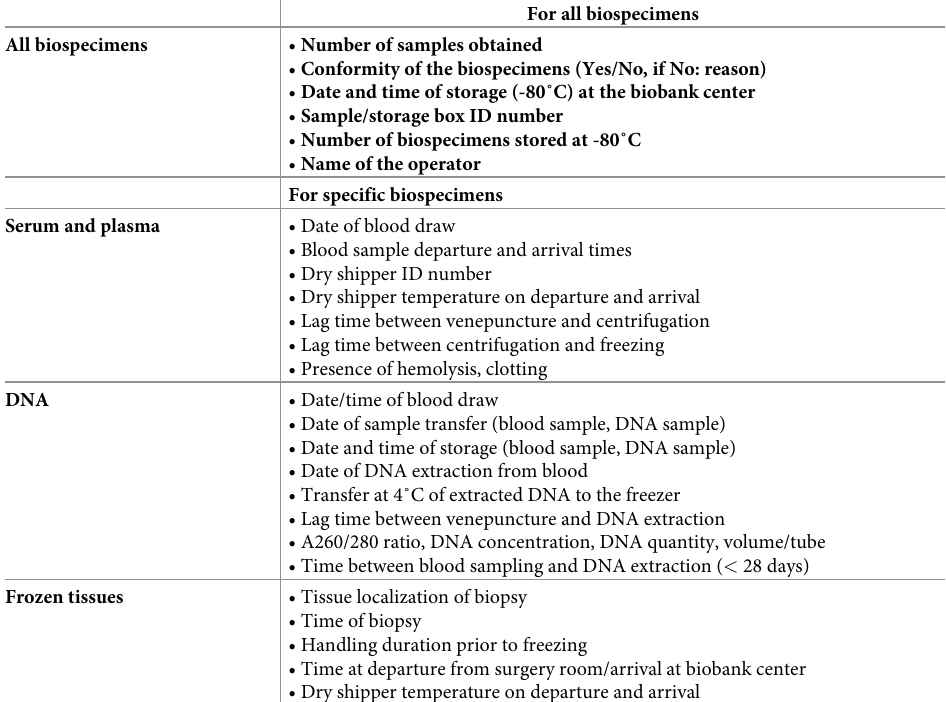
Table 1. Relevant biospecimen information recorded on the sample tracking